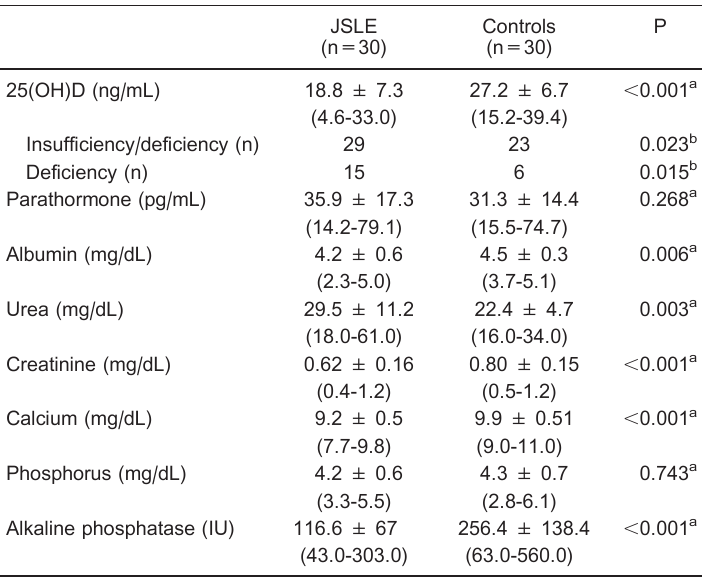
Table 2. Serum concentrations of 25(OH)D and laboratory markers of patients with juvenile systemic lupus erythematosus (JSLE) and